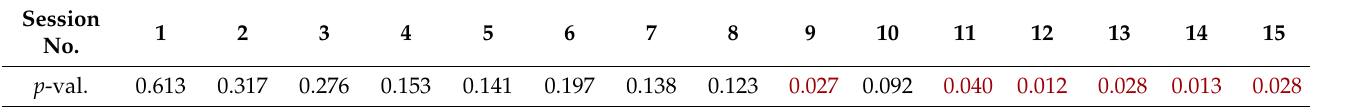
Table 3. Results of the Kolmogorov–Smirnov test. The p -values lower than 0.05 (which means they do not come from the standard normal distribution) are marked in red.